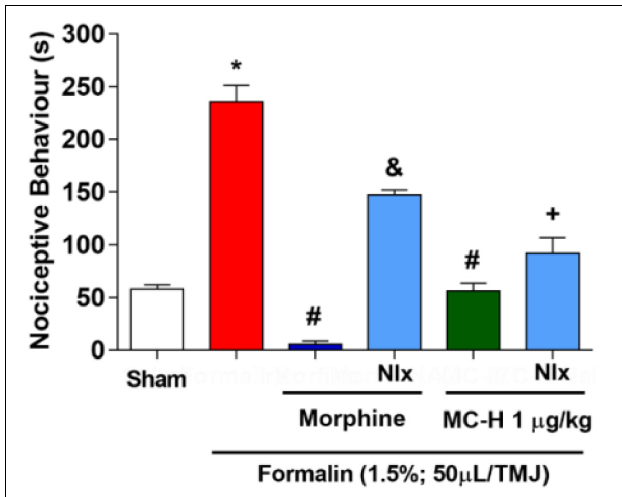
FIGURE 6 | MC-H-induced antinociception depends on central opioids receptors. Administration of MC-H (1 µ g/kg; po ) significantly decreased the nociceptive behavior induced by 1.5% formalin in the TMJ. Pre-treatment of naloxone (Nlx), a non-selective opioid antagonist, affected the antinociception induced by MC-H. The symbols (*), (#), (&), and (+) represent statistically significant differences compared with saline, formalin, morphine, and MC-H groups, respectively. ( p < 0.05: ANOVA, Games-Howell